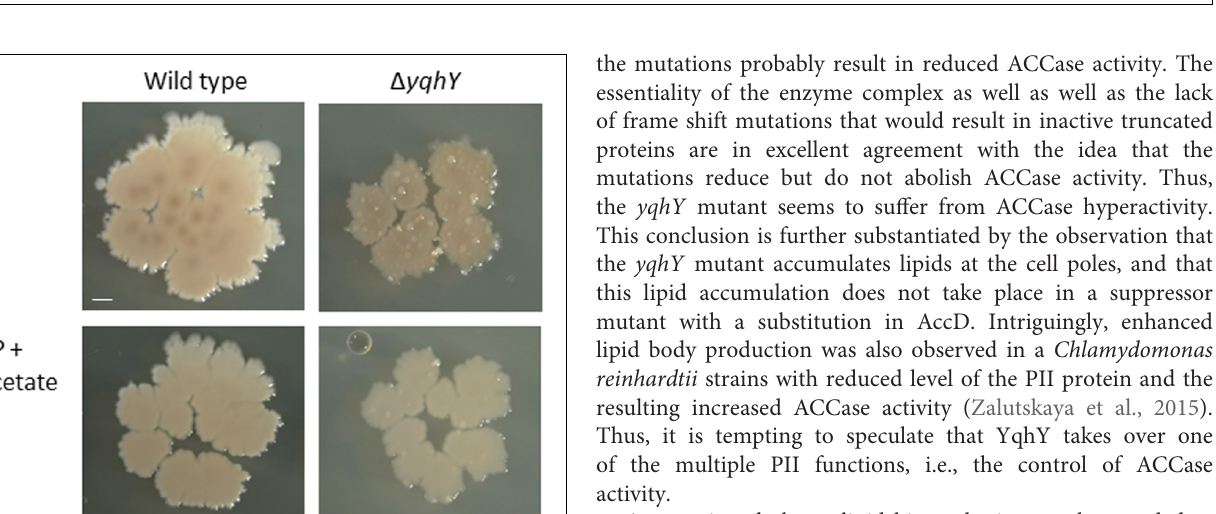
FIGURE 5 | Staining of lipophilic regions. Samples were taken at exponential growth phase and treated with the membrane dye Nile Red. The lowest panel shows individual cell in 35-fold magnification. Scale bar, 5 µ m.